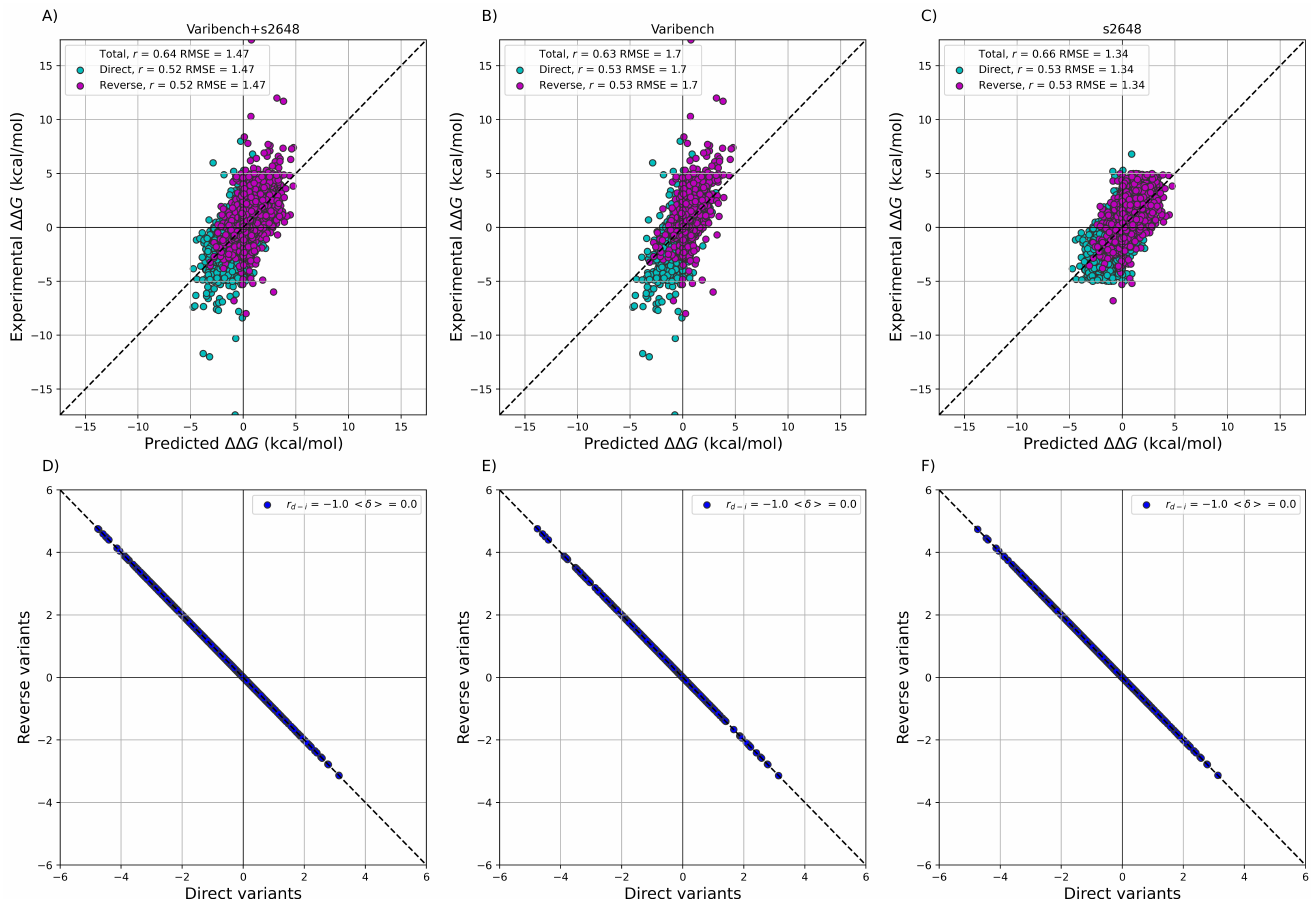
Figure 3. Performance of ACDC-NN-Seq on predicting ∆∆ G for the direct and reverse variations on: ( A ) Varibench and S2648 ( r = 0.52, RMSE = 1.47 kcal/mol); ( B ) Varibench alone ( r = 0.53, RMSE = 1.7 kcal/mol); ( C ) S2648 alone ( r = 0.53, RMSE = 1.34 kcal/mol). Direct versus reverse ∆∆ G values of ( D ) Varibench and S2648 variations, ( E ) Varibench variations alone, ( F ) S2648 variations alone, predicted by ACDC-NN-Seq, with a Pearson correlation of r d − i = − 1.0 and (cid:104) δ (cid:105) = 0.00 kcal/mol for all three datasets. All the predictions reported in this figure were obtained through a 10-fold cross-validation with sequence identity <25% among all